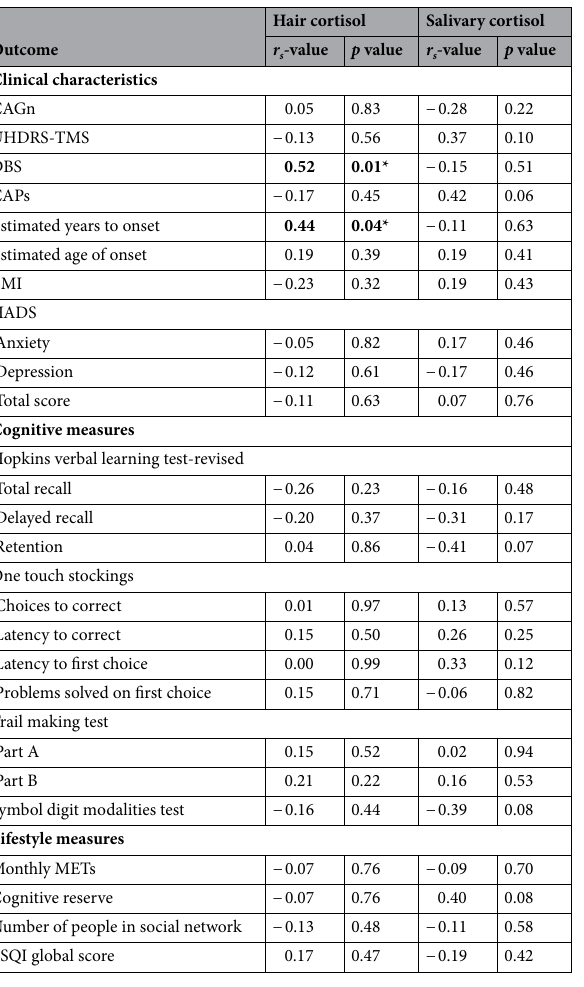
Table 3. Spearman’s partial correlations between clinical variables and hair and salivary cortisol in individuals with premanifest HD. Data was assessed using Spearman’s partial correlations. Age, sex and disease burden score were controlled for in all analyses, except for correlations between hair and salivary cortisol and disease burden score, in which age and sex were control variables. Correlations were considered significant at p < 0.05 (bolded values) and r s -values were considered small, medium and large at r s < 0.30, r s > 0.30 to < 0.5 and r s > 0.5, respectively. CAGn cytosine-adenine-guanine trinucleotide repeat number, UHDRS-TMS Unified